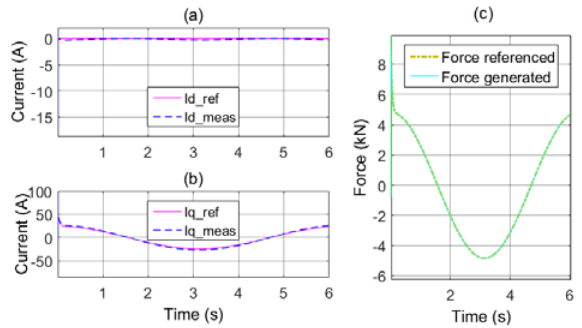
Fig. 8. Controller tracking in Case I. (a) d -axis referenced and measured currents; (b) q -axis referenced and measured currents; (c) Force- referenced and the forcegenerated in Case